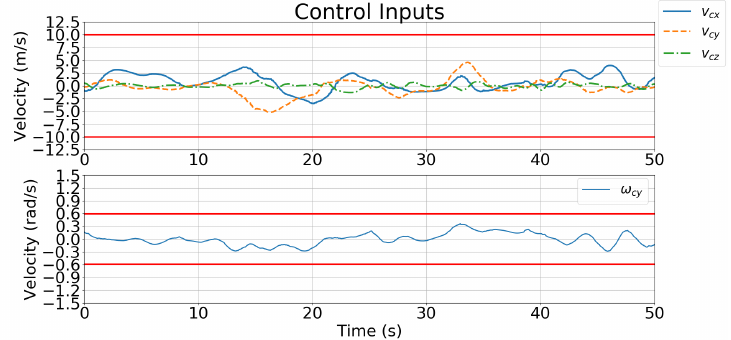
Figure 18. Simulation 2: velocity control input for Case